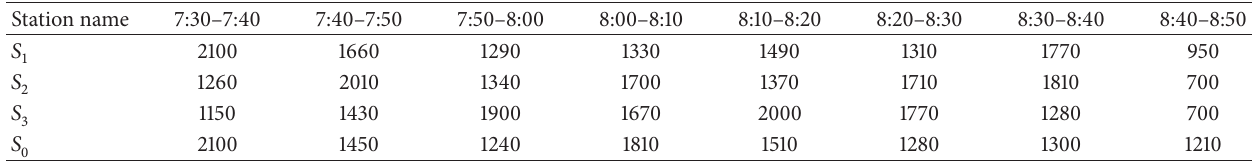
Table 4: Example of optimal solution.